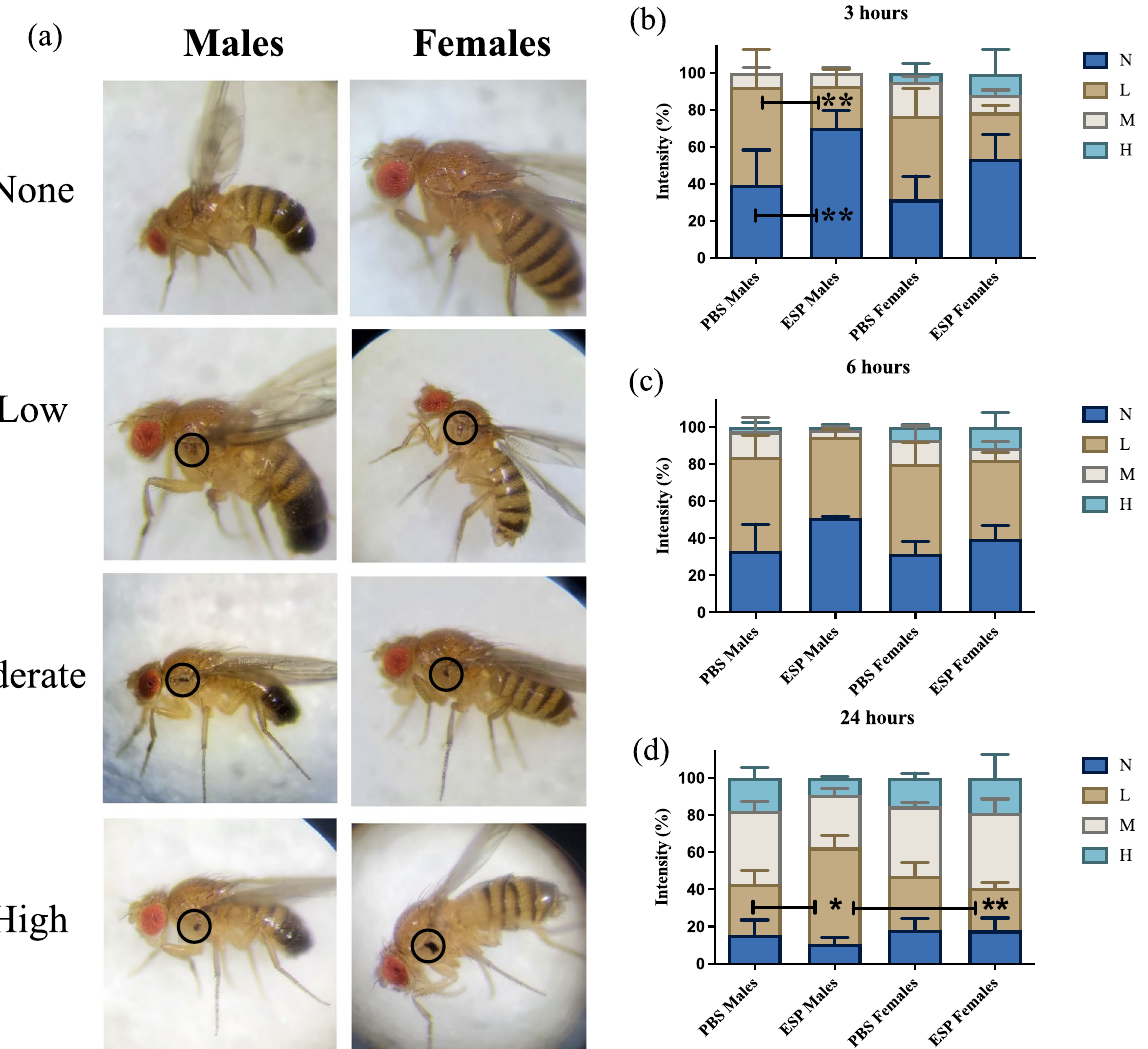
Figure 5. Steinernema carpocapsae nematode excreted/secreted products (ESPs) affect the melanization response in Drosophila melanogaster . ( a ) Qualitative categorization of the degree of melanization displayed in male and female adult flies; None = no visible signs of a melanin spot at the injection site, Low = visible melanin spot that is less than or equal to the size of the injection site and the pigment is translucent, Moderate = melanin spot that is equal to the size of the injection site with pigment semi-opaque to fully opaque, High = melanin spot that is greater than the size of the injection site with hyperpigmentation that is opaque. Adult flies of the Oregon-R line were divided into male and female groups and then injected with 3 ng of S. carpocapsae ESPs or PBS as a control and observed at ( b ) 3 h, ( c ) 6 h, and ( d ) 24 h for changes in melanization intensity (N = None, L = Low, M = Moderate, and H = High). * P < 0.05, ** P < 0.01; Two-way